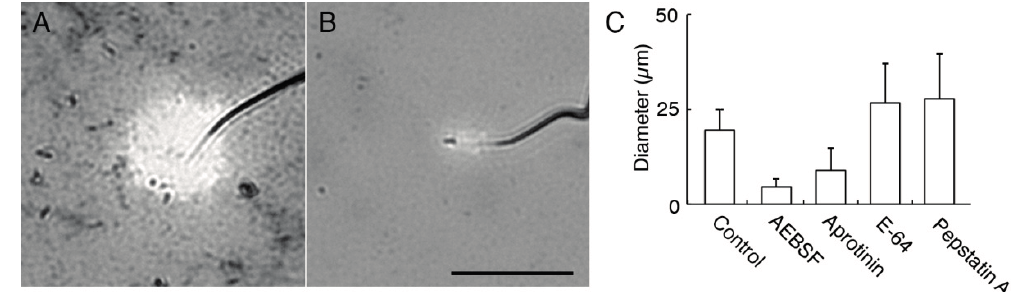
Figure 2. Inhibitory effects of protease inhibitors on halo formation. One of the four kinds of protease inhibitors—AEBSF (4-(2-aminoethyl) benzenesulfonyl fluoride), aprotinin, E-64, and pepstatin A—were added to sperm suspension and smeared on gelatin film. Diameter of halos around the tip of sperm head was measured. ( A , B ): Halos around sperm without treating with any inhibitors as control ( A ) and AEBSF-treated sperm ( B ). Bar: 25 µm; ( C ) Diameters of the halo around sperm in treatment with protease inhibitors.